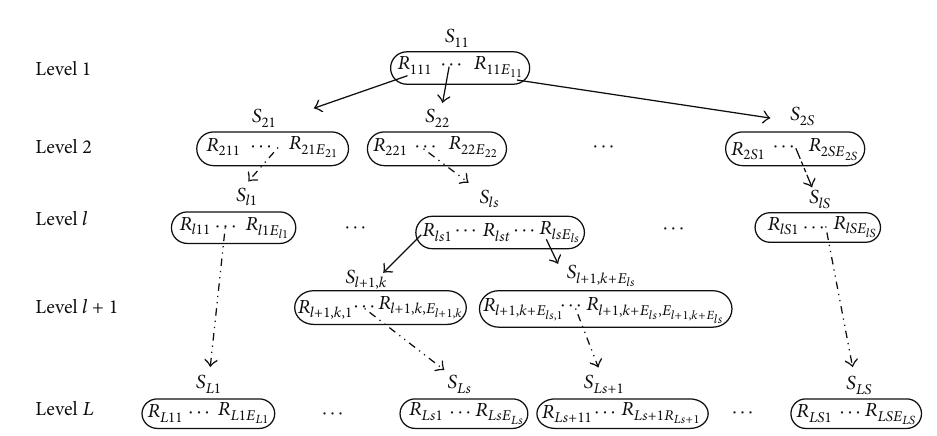
Figure 7: An example of e-healthcare architecture.